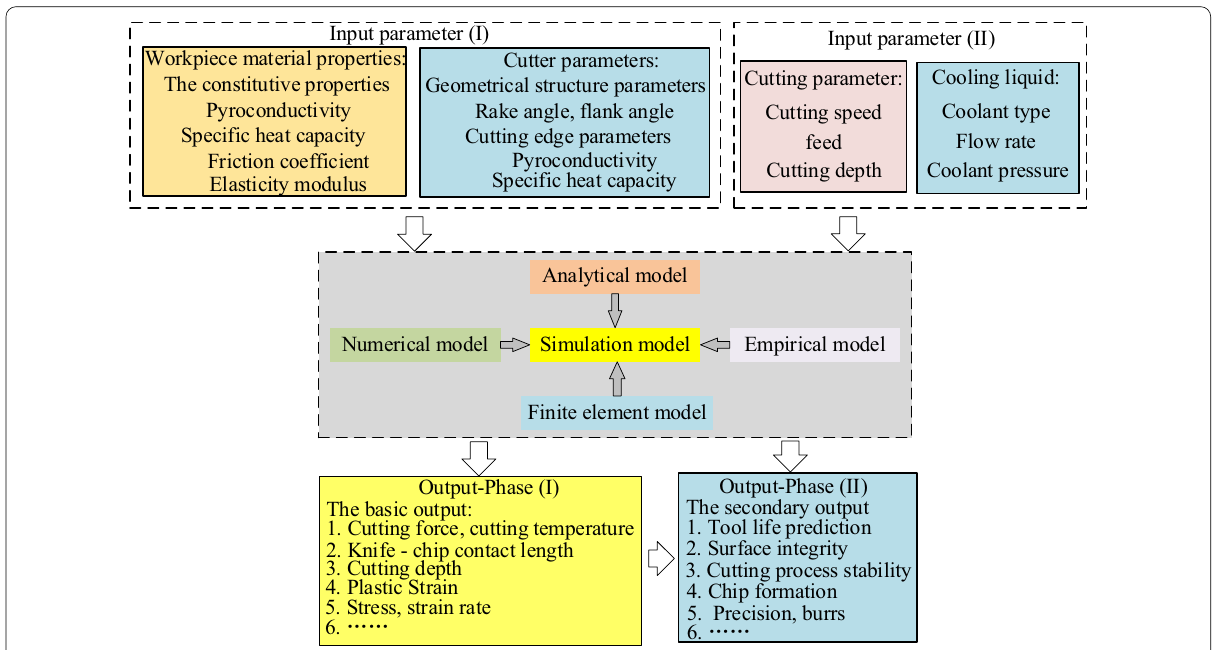
Figure 7 Factors involved in milling process simulation and results output